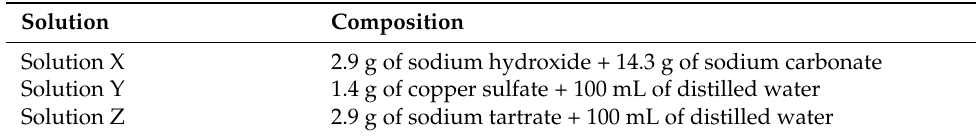
Table 1. Composition of Solution X, Solution Y and Solution